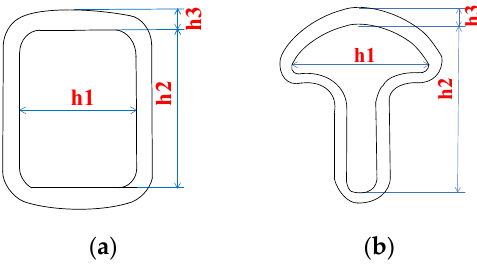
Figure 1. Schematic diagram of the cross-section of the composite cross-arms ( a ) square-shaped; ( b ) T-shaped. Table 1. 10 kV Composite Cross-Arm Structural Parameters.